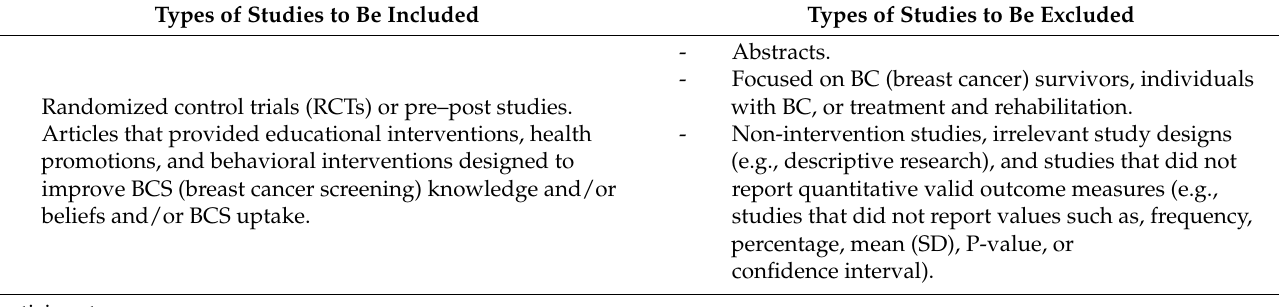
Table 1. Inclusion and exclusion